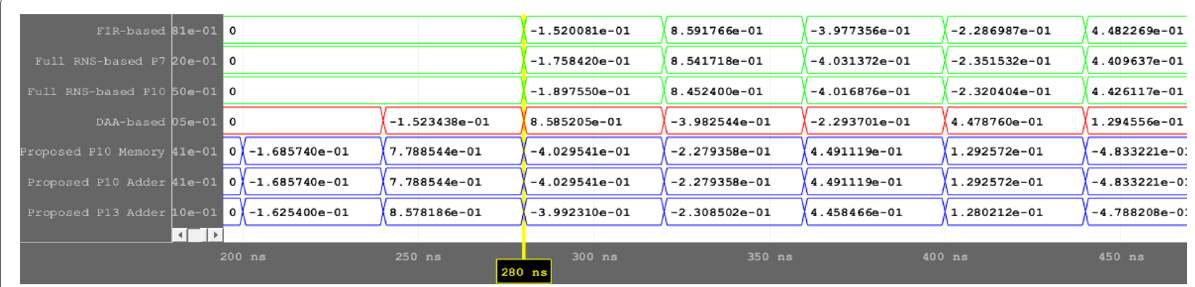
Fig. 10 The output of two-level DWT using DSP Logic Analyzer when a sin wave is applied. Each clock cycle is 10 ns